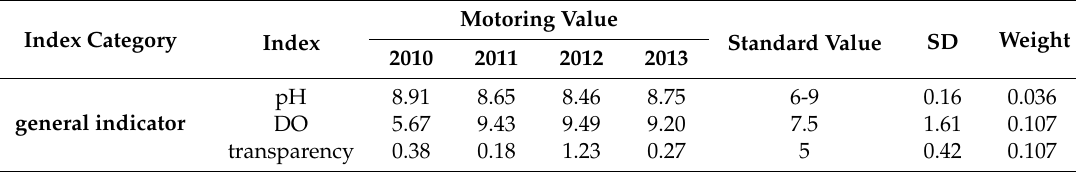
Table 4. Indicator data used to establish the water quality